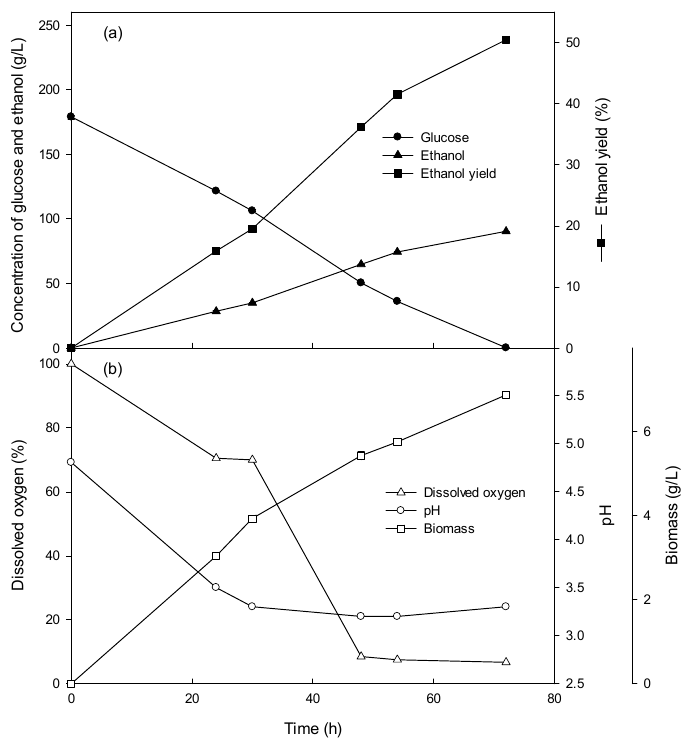
Figure 4. Time course of ( a ) glucose, ethanol concentration, and ethanol yield change, ( b ) dissolved oxygen, pH, and biomass in the batch cultures of S. cerevisiae BCRC 21812. The initial glucose concentration was 18% ( w / v ).